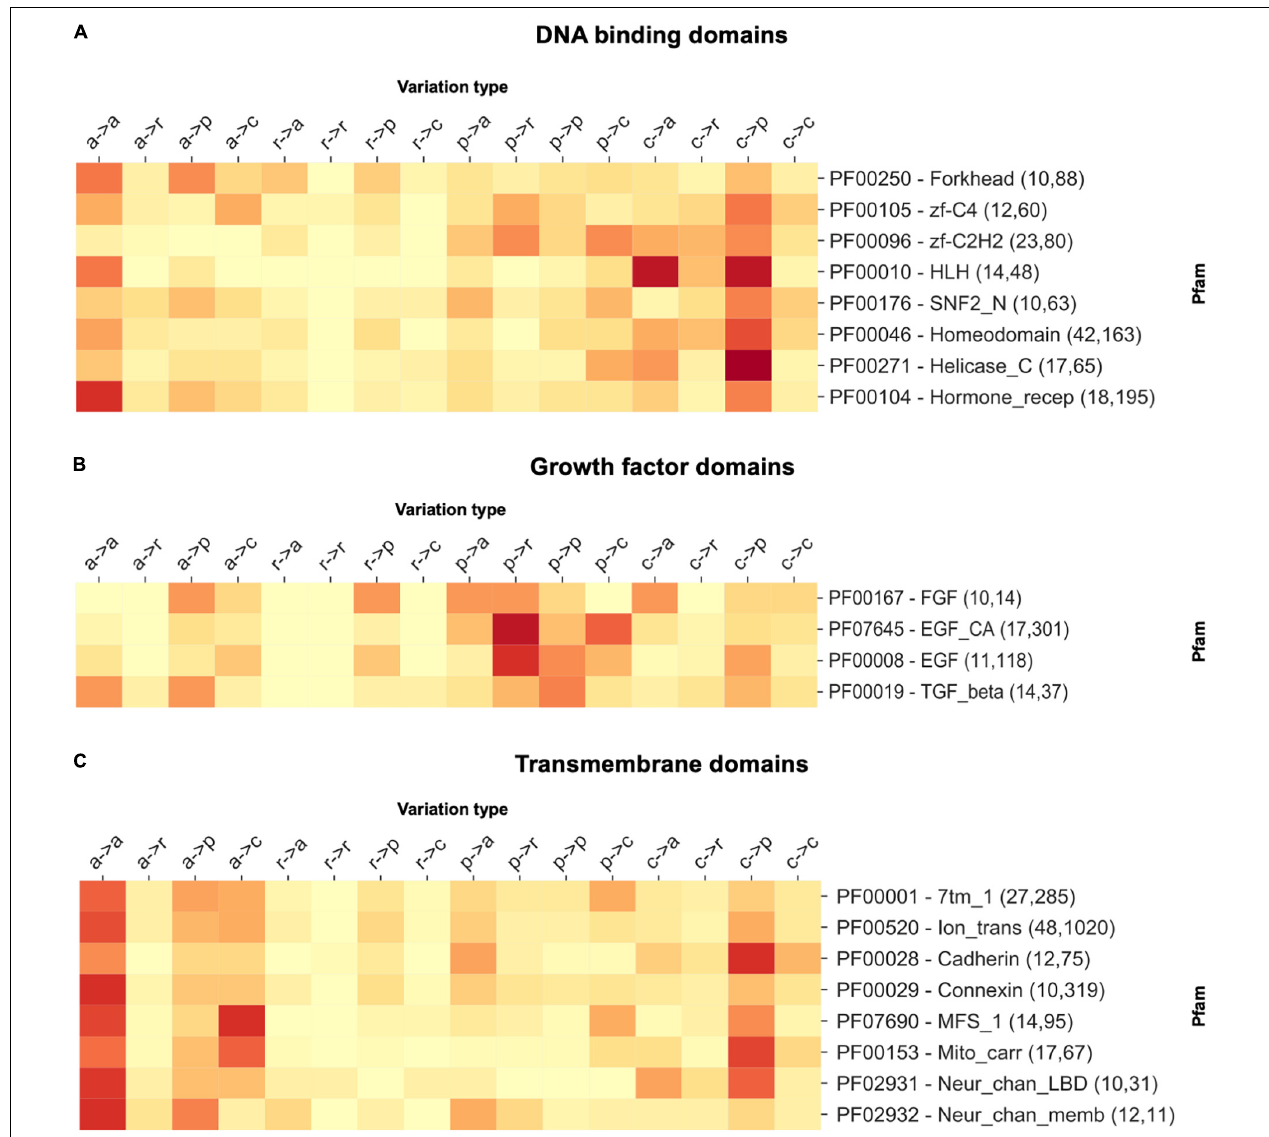
FIGURE 2 | The heatmap reporting the frequency of each variation type as observed within a selection of (A) DNA-binding, (B) growth factor, and (C) transmembrane domains. For each Pfam, the numbers within parentheses indicate the number of proteins and disease-related variations covered. In variation types, labels are as follows: a, apolar; r, aromatic; p, polar; and c,